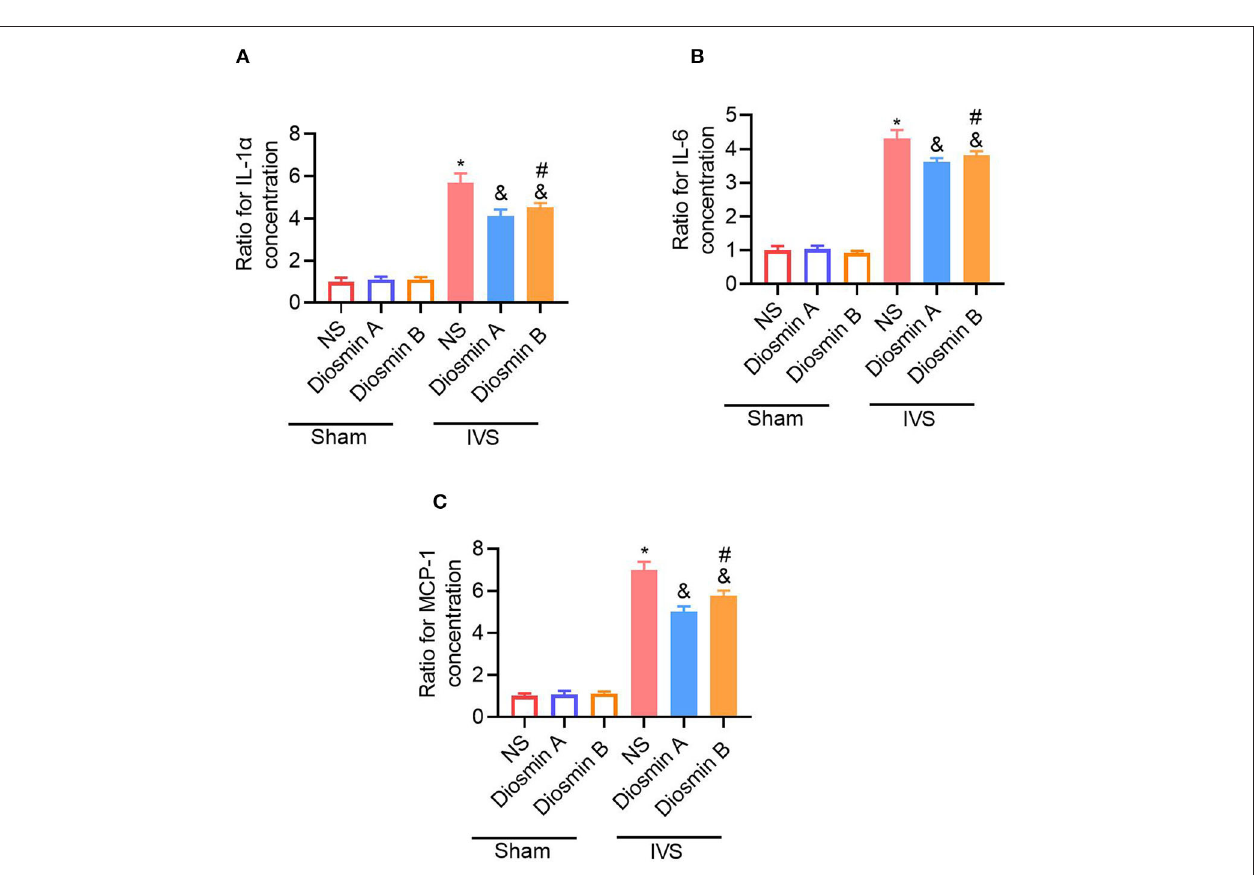
FIGURE 4 | Diosmin suppresses inflammatory response in a mouse model of iliac vein stenosis. The SM muscle inflammatory cytokines IL-1 α (A) , IL-6 (B) , and MCP-1 (C) mRNA levels were measured with quantitative real-time PCR (qRT-PCR). The number of target genes was normalized to the average of the sham/NS group using the 2 − 11 Ct method. Sham/NS ( n = 3), sham/diosmin A ( n = 3), sham/diosmin B ( n = 3), IVS/NS ( n = 6), IVS/diosmin A ( n = 7), and IVS/diosmin B ( n = 7). * p < 0.05 vs. sham/NS; & p < 0.05 vs. IVS/NS; # p < 0.05 vs. IVS/diosmin A (Unpaired t -test). IVS, iliac vein compression; IL-1 α , interleukin-1 α ; MCP-1, monocyte chemoattractant